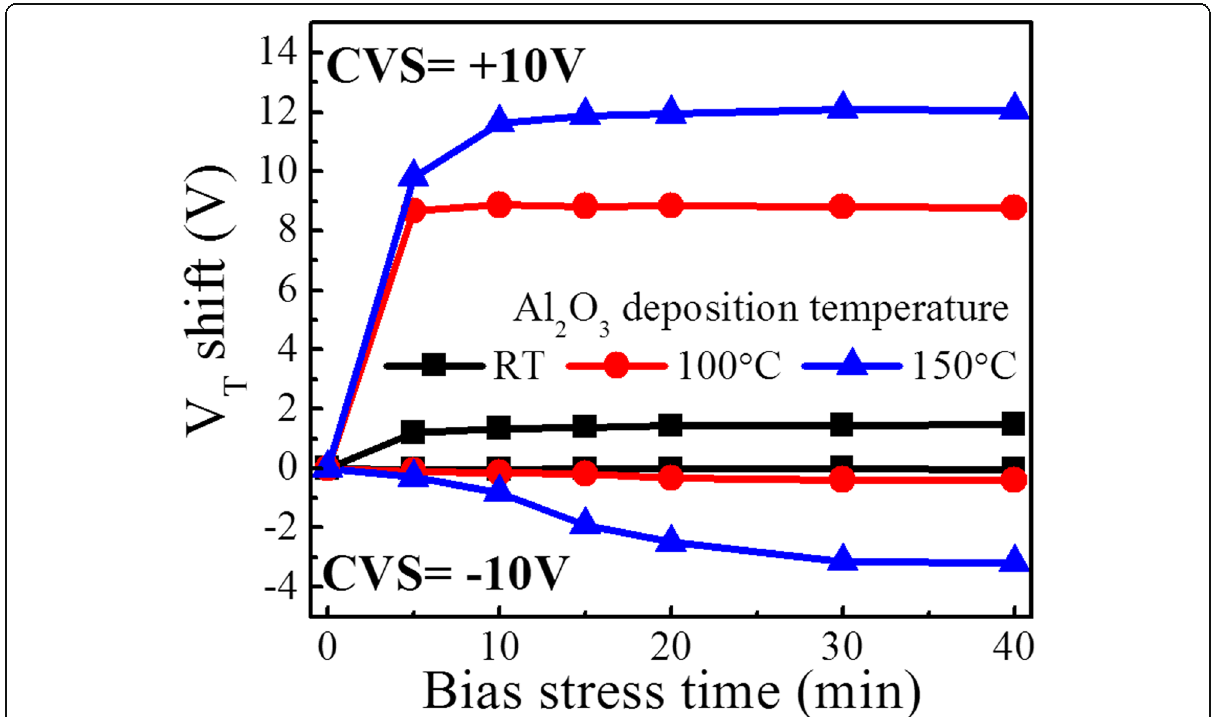
Fig. 3 V T shift as a function of bias stress time under NGBS = − 10 V and PGBS = 10 V for the TFTs with Al 2 O 3 insulators deposited at different